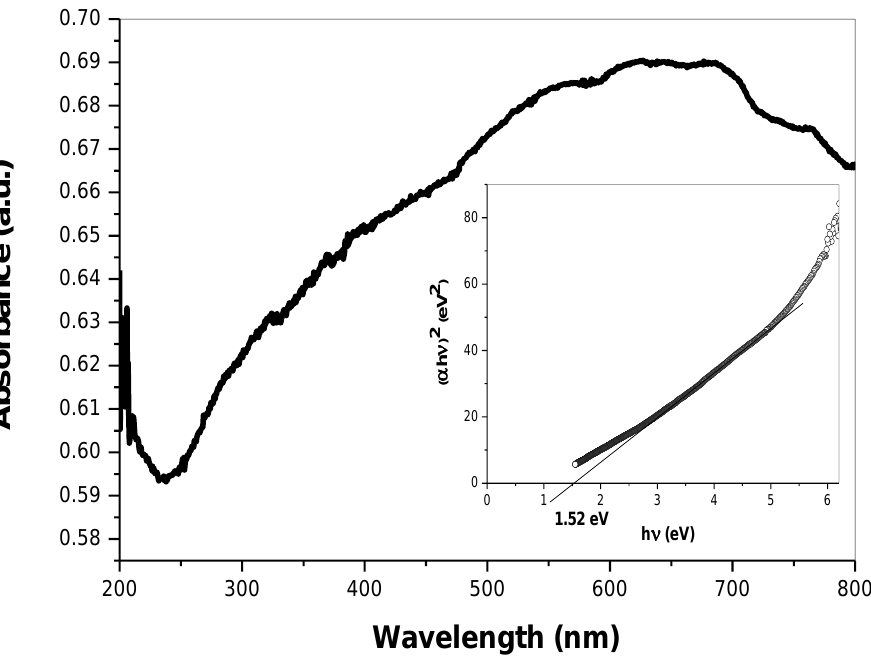
Figure 6. Wavelength-dependent absorbance of mechanochemically synthesized Cu 3 BiS 3 after 5 min of milling. The inset shows a Tauc plot for determining the optical bandgap.